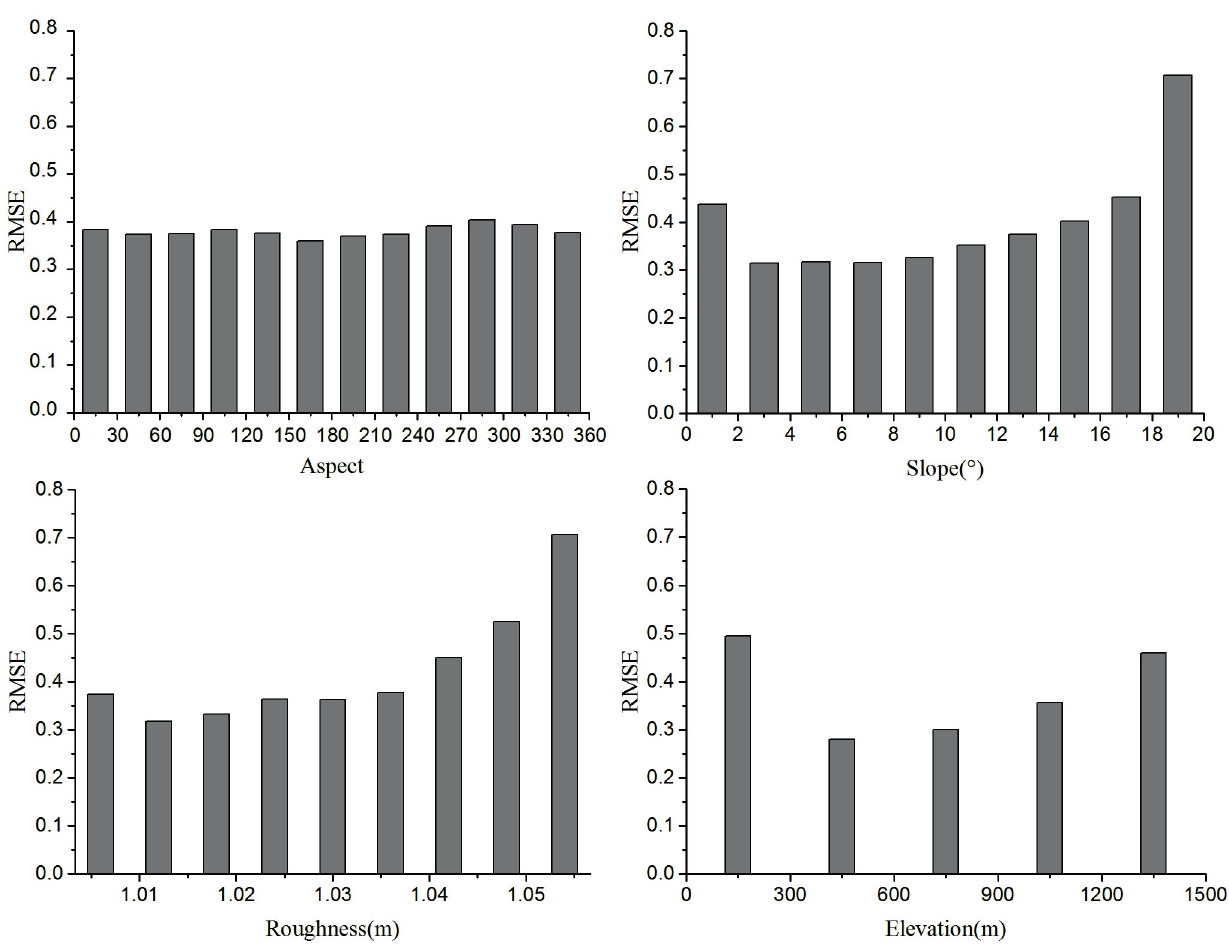
Figure 9. RMSE as a function of aspect, slope, roughness and elevation in shrublands and